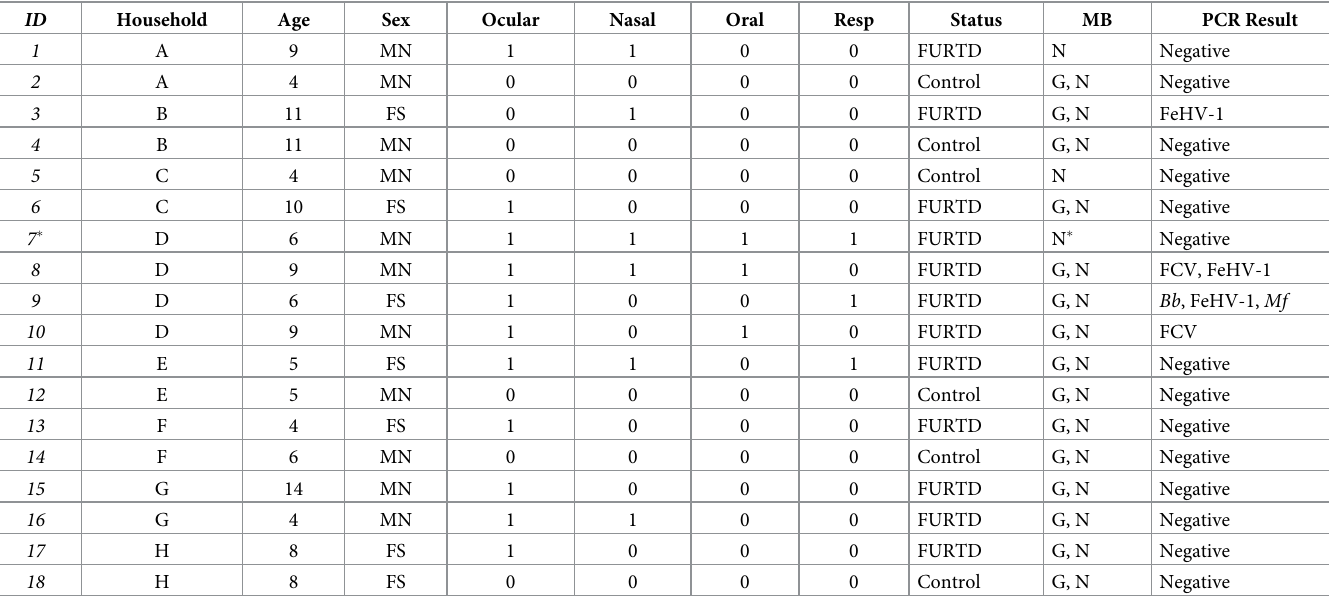
Table 1. Study population